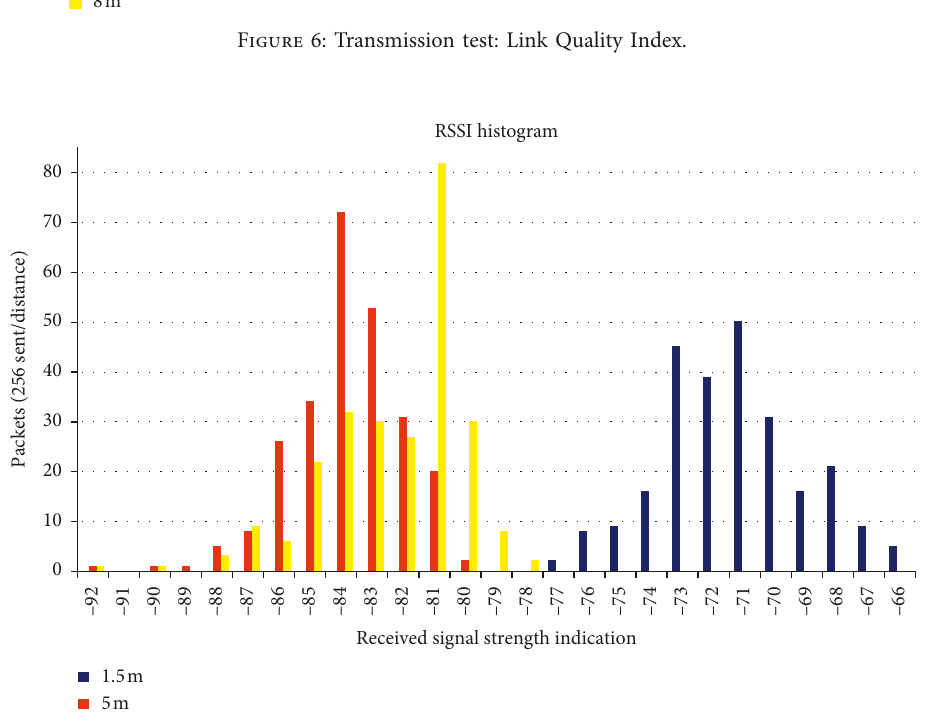
Figure 7: Transmission test: RSSI histogram.